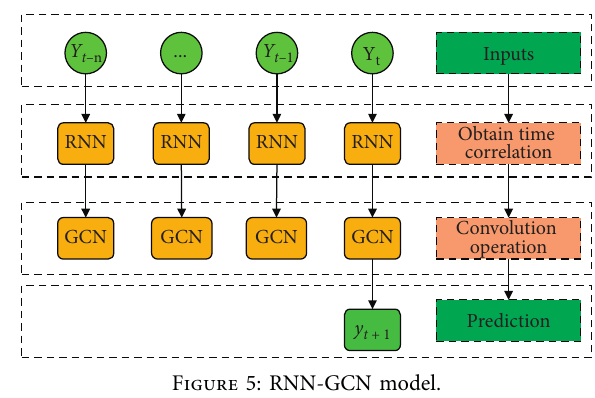
Figure 5: RNN-GCN model.